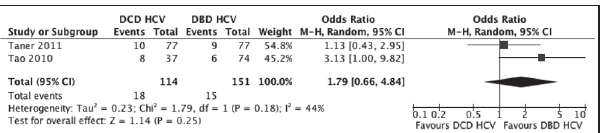
Figure 6) Forest plot of primary nonfunction. DBD Donation after brain death; DCD Donation after cardiac death; HCV Hepatitis C virus